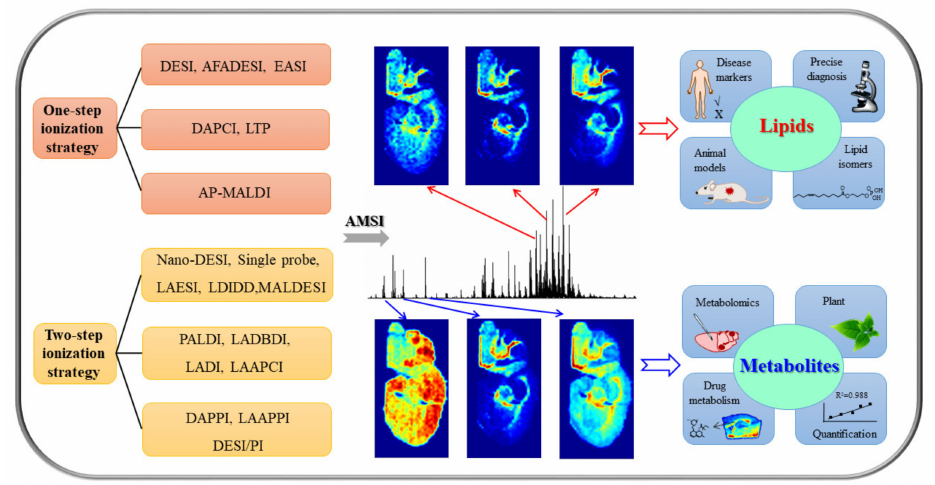
Figure 1. The schemes of ambient mass spectrometry imaging for lipid and metabolite analysis. DESI: desorption electrospray ionization; AFADESI: airflow-assisted desorption electrospray ion- ization; EASI: easy ambient sonic spray ionization; DAPCI: desorption atmospheric pressure chemical ionization; LTP: low-temperature plasma; AP-MALDI: atmospheric pressure matrix-assisted laser desorption/ionization; Nano-DESI: nanospray desorption electrospray ionization; LAESI: laser ablation electrospray ionization; LDIDD: laser desorption/ionization droplet delivery; MALDESI: matrix-assisted laser desorption electrospray ionization; PALDI: plasma-assisted laser ionization; LADBDI: laser ablation dielectric barrier discharge ionization; LADI: laser ablation direct analysis in real time; LAAPCI: laser ablation atmospheric pressure chemical ionization; DAPPI: desorption atmospheric pressure photoionization; LAAPPI: laser ablation atmospheric pressure photoionization; DESI/PI: desorption electrospray